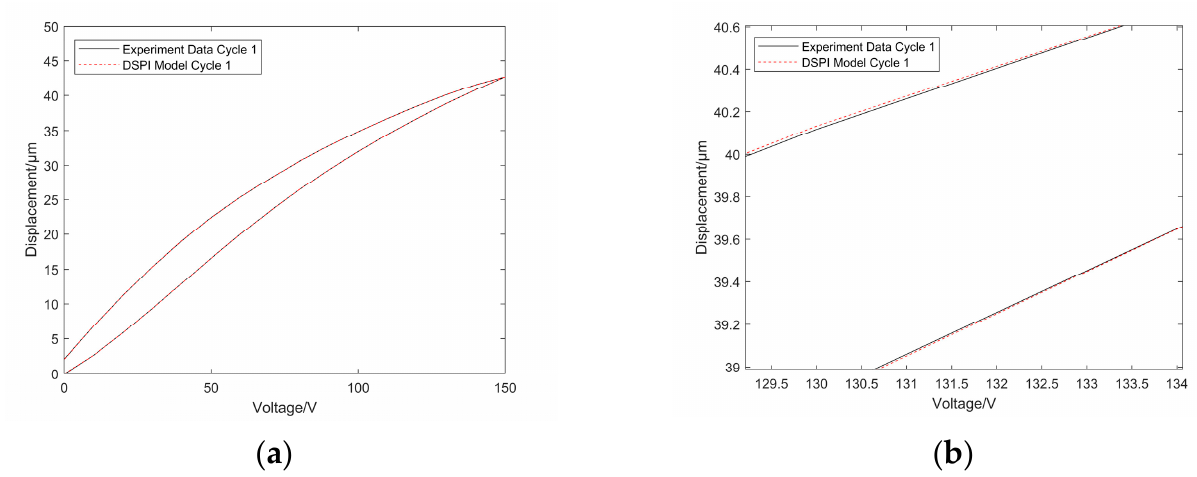
Figure 15. DSPI model: ( a ) modeling of the first cycle data hysteresis characteristics; ( b ) local enlargement.